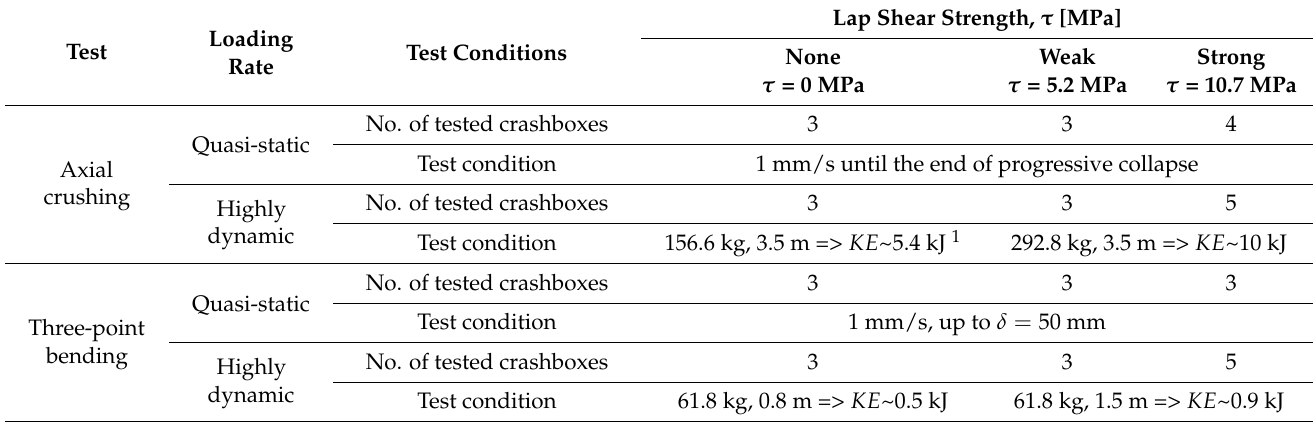
Figure 4. ( a ) Highly dynamic and ( b ) quasi-static three-point bending test of the top-hat crashboxes. Table 2. Experimental test program for axial crushing and three-point bending tests.